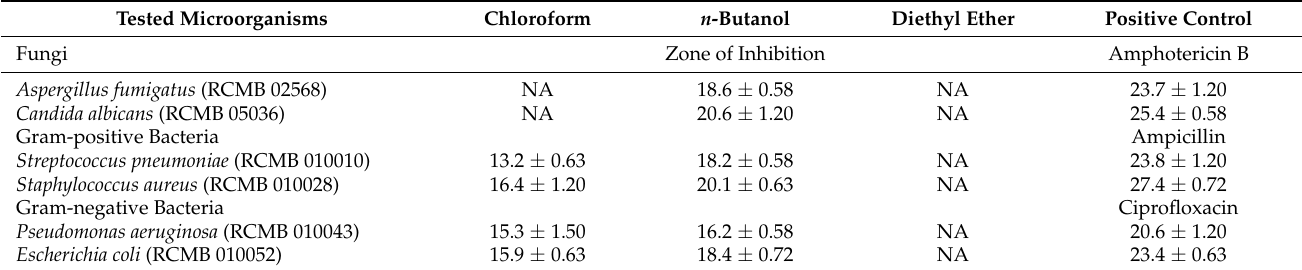
Table 1. Antimicrobial effects of various stem bark fractions of Z. spina-christi L. Tested Microorganisms Chloroform n -Butanol Diethyl Ether Positive